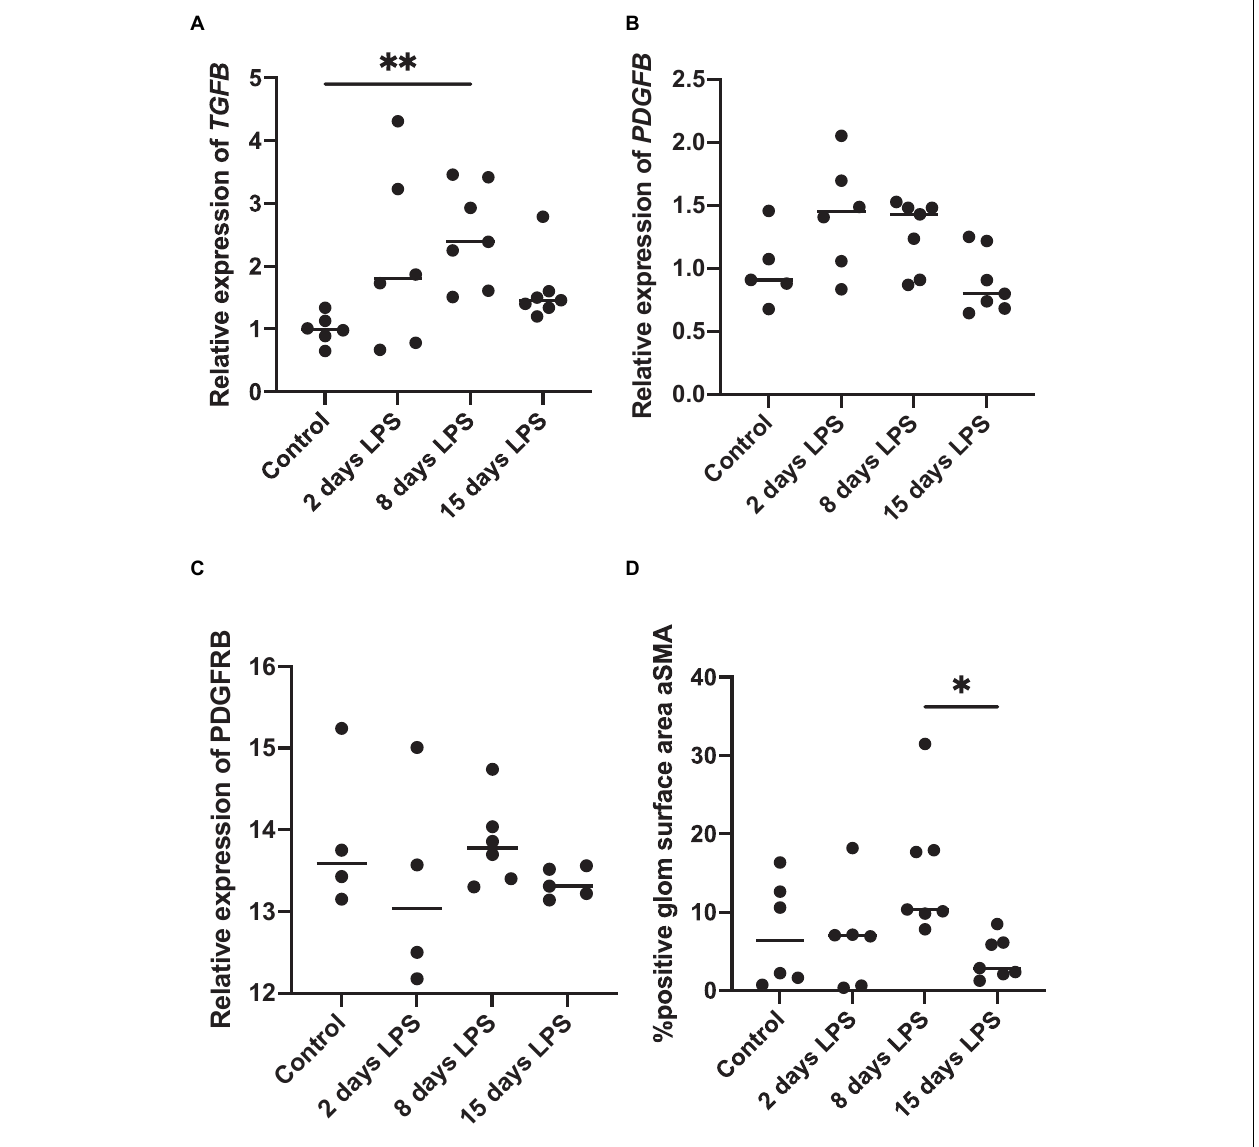
FIGURE 3 | Expression of mesangial pro-fibrotic markers. Each point represents an individual animal, horizontal line marks the median. Data was analyzed using Kruskal–Wallis test and post hoc Dunn’s test. (A) qPCR relative expression of transforming growth factor beta ( TGFB ), ∗∗ p < 0.01 compared with control; (B) qPCR relative expression of platelet derived growth factor b ( PDGFB ); (C) qPCR relative expression of platelet derived growth factor receptor b (PDGFRB); (D) Average percentage of glomerular surface area positive for alfa-smooth muscle actin (aSMA) on immunohistochemistry, ∗ p < 0.05 compared with 15 days LPS.